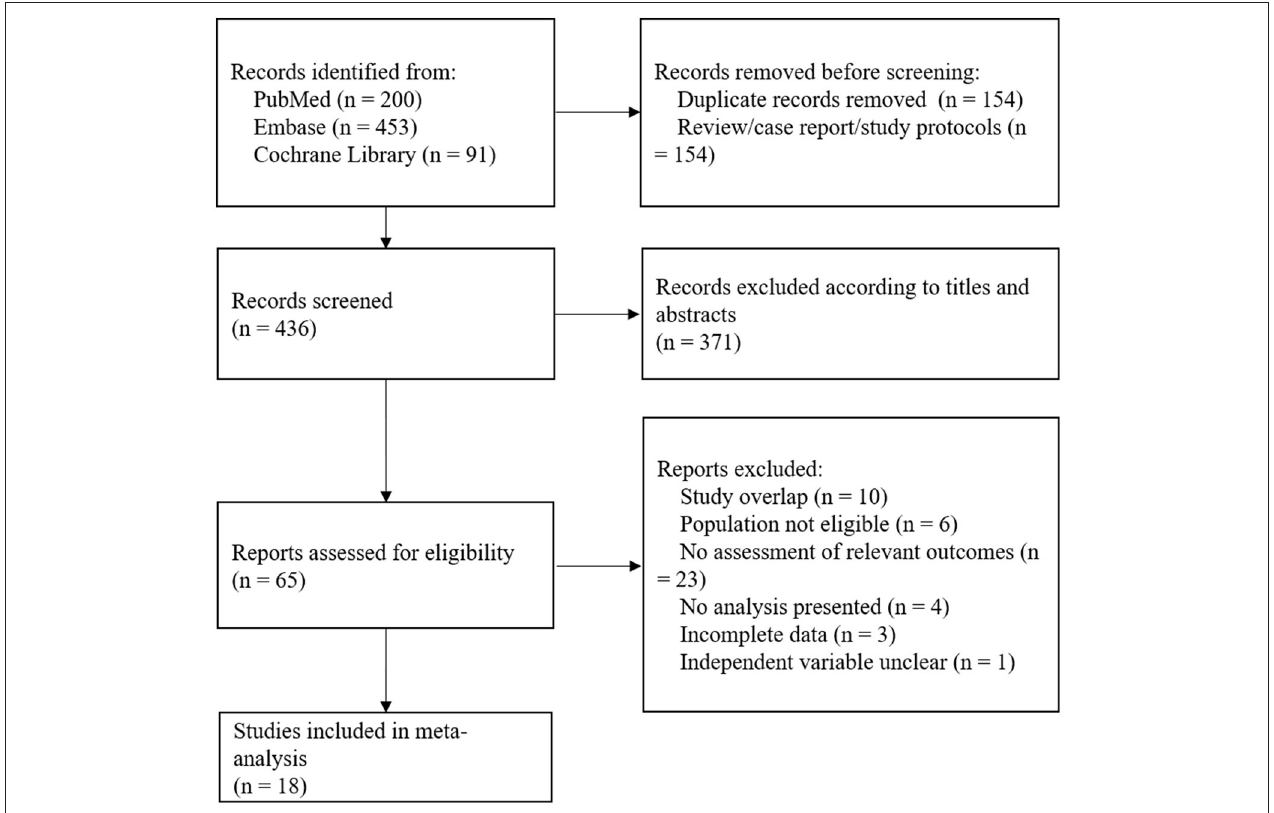
FIGURE 1 | A flow diagram of study selection details. A total of 744 articles were screened for eligibility, and 18 studies were included in the